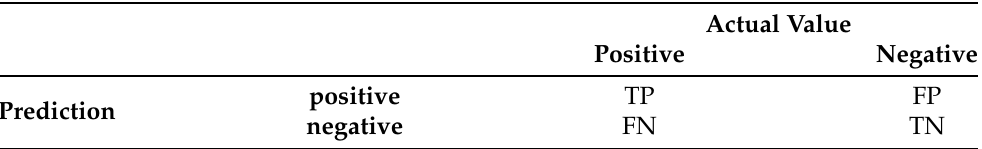
Table 3. Confusion matrix format for binary classification, with depicted true positives (TP), false negatives (FN), false positives (FP), and true negatives (TN)